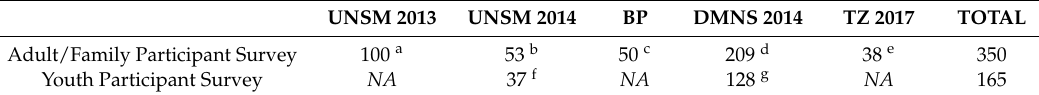
Table 6. Overview of venues of ELE and sample sizes for evaluation data. Hosting sites included the University of Nebraska State Museum’s Morrill Hall (UNSM 2013 & 2014) in Lincoln, NE; the Butterfly Pavilion (BP) in Westminster, CO; the Denver Museum of Nature and Science (DMNS) in Denver, CO; and the Toledo Zoo (TZ) in Toledo, OH. Youth surveys were not collected at UNSM 2013, BP, or TZ (see NA—Not Applicable ). UNSM 2013 UNSM 2014 BP DMNS 2014 100 a 53 b 50 c 209 d 350 37